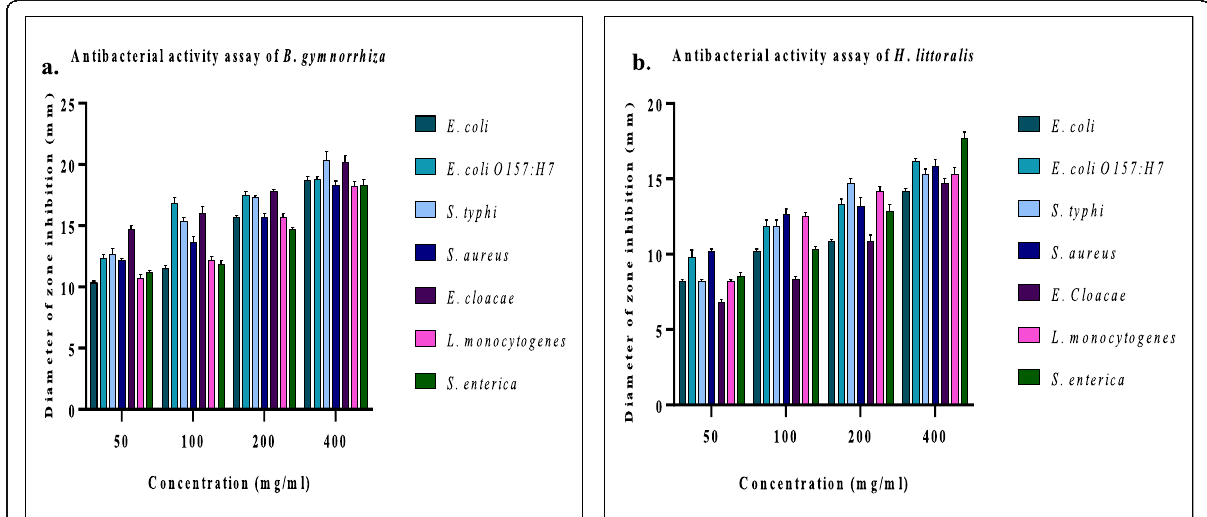
Fig. 3 Concentration-dependent antibacterial activity of (a) B. gymnorrhiza and (b) H. littoralis . Values are expressed as Mean ± SEM ( n =